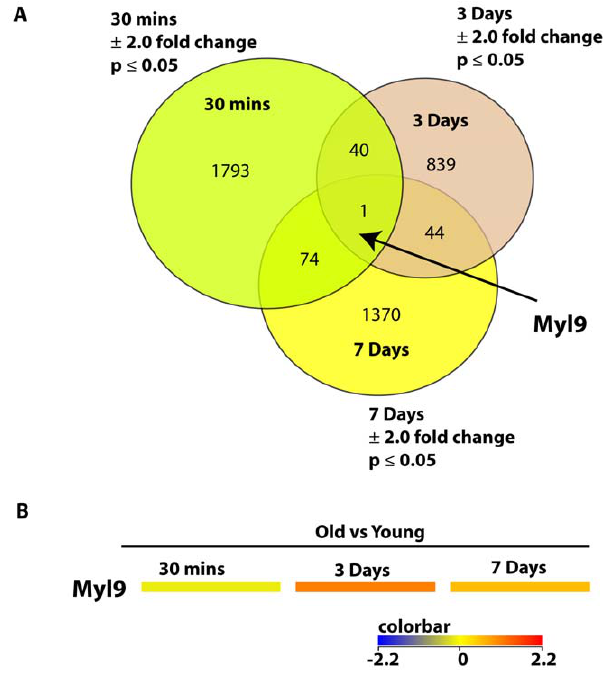
Figure 1. Differentially expressed genes overlapping in multiple time points in old versus young injured rat iliac arteries. A. Venn diagram shows the number of differentially expressed genes determined by our analysis of 3 different time points in old versus young injured rat iliac arteries. Gene lists were compared to find common differentially expressed transcripts. A 2.0 fold change and p , .05 significance cut-offs were used. No multiple correction was employed. B. Heat map of Myl9 gene expression levels in multiple time points in old versus young injured rat iliac arteries. Myosin Light chain 9, Myl9, was significantly downregulated at 30 mins ( 2 2.2 fold), highly upregulated at 3 days (4.6 fold), and upregulated at 7 days (2.9 fold). Color bar shown in Log 2 .